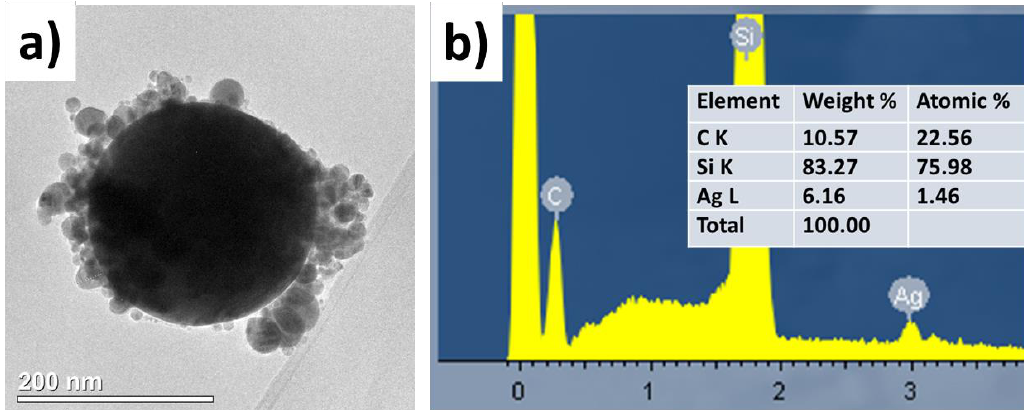
Figure 3 . ( a ) TEM visualization of single Ag nanoparticle laser-transferred from the PET substrate; ( b ) Data (spectrum and datasheet) of its energy dispersive x-ray spectroscopy analysis on the acceptor Si substrate, which also appears in the spectrum .